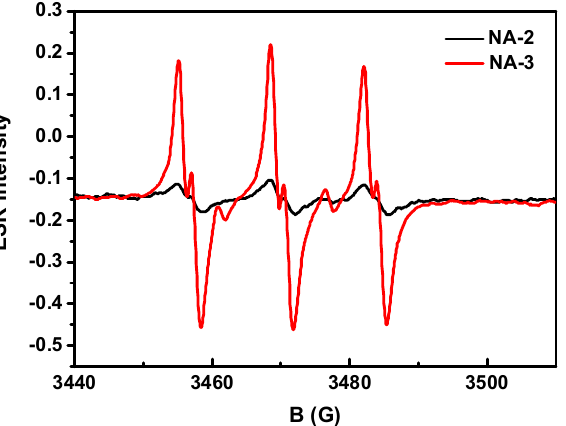
Figure 5. Experimental ESR spectra of the radicals generated by NA-2 or NA-3 irradiated with a UV lamp for 3 min and trapped by N- tert -Butyl- α -phenylnitrone (PBN) in t-butylbenzene solution.